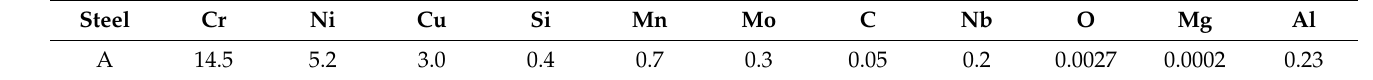
Table 2. Chemical composition of premelted slag (Mass percentage).